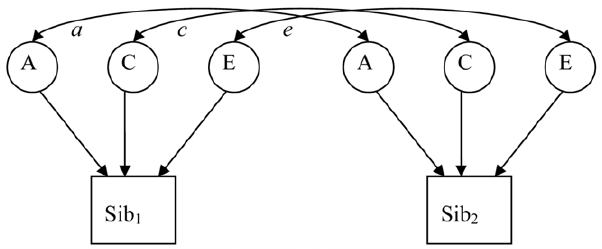
Figure 1. Path diagram (above) and parameter values (below) for model fitting. a =covariance in additive genetics and c =covari- ance in shared environment between siblings. Values for a represent the strongest form of the model assumed.